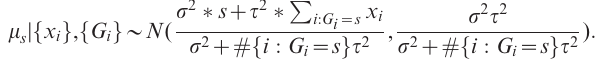
Figure S3 Comparison of segmentation methods on Chromosome 7 of a GBM sample. Figure S4 Comparison of segmentation methods on Chromosome 10 of a GBM